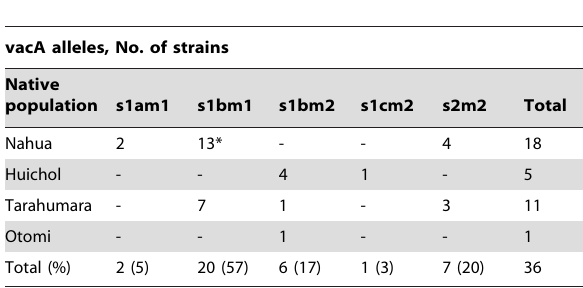
Table 5. Characteristics of 35 individuals from Mexican indigenous groups and their H. pylori isolated